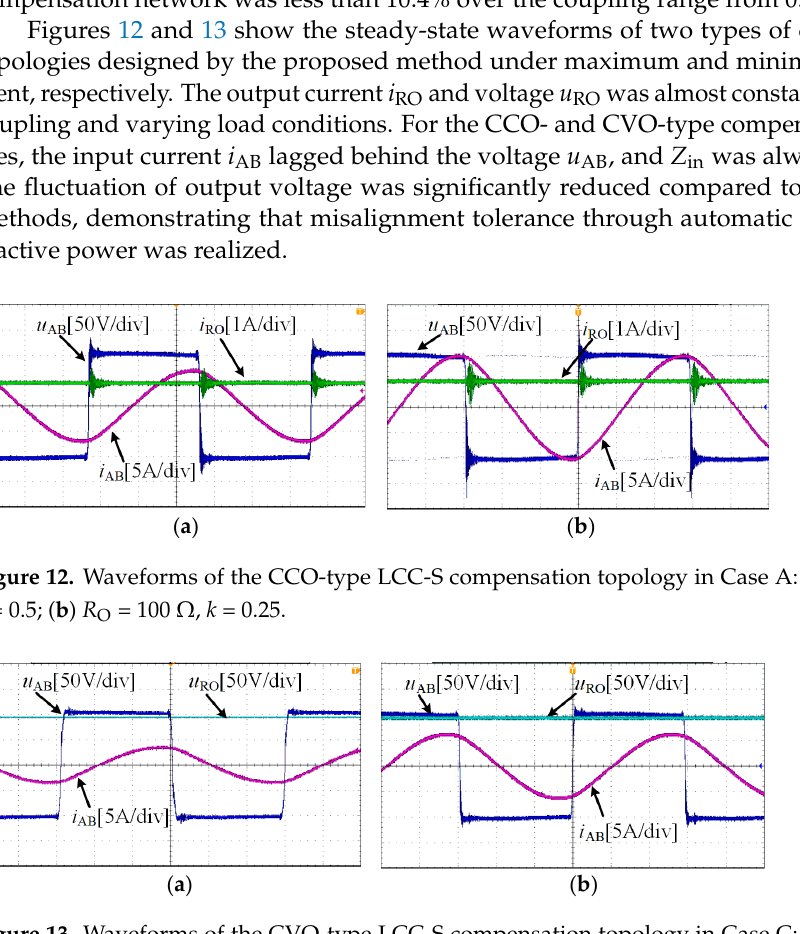
Figure 11. Normalized output currents and voltages of the LCC-S compensation topology designed by the new method.